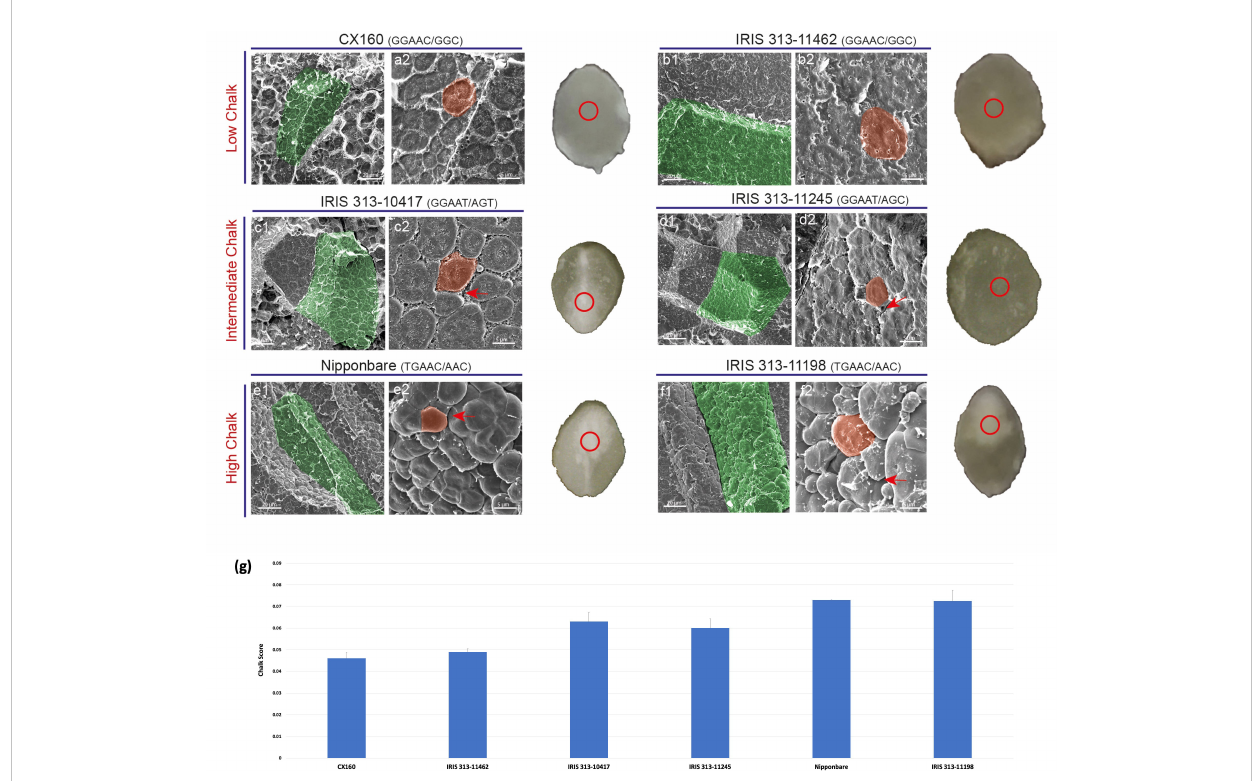
FIGURE 8 Scanning electron micrographs of transversely fractured mature rice seeds. (A1-B2) Endosperm cell (green) of low chalk genotypes is tightly packed with starch grains (orange). (C1-D1) Micrographs of intermediate chalk genotypes with slightly bulged starch granules with visible spaces between individual amyloplasts. (E1-F2) Images of transversely cut chalky endosperm region fi lled with spherical starch grains instead of polygonal as in a1 and b1. Air spaces (shown by red arrows) can be seen between the grains in e1 and f1. The red circle on a transverse cut seed shows the region selected for